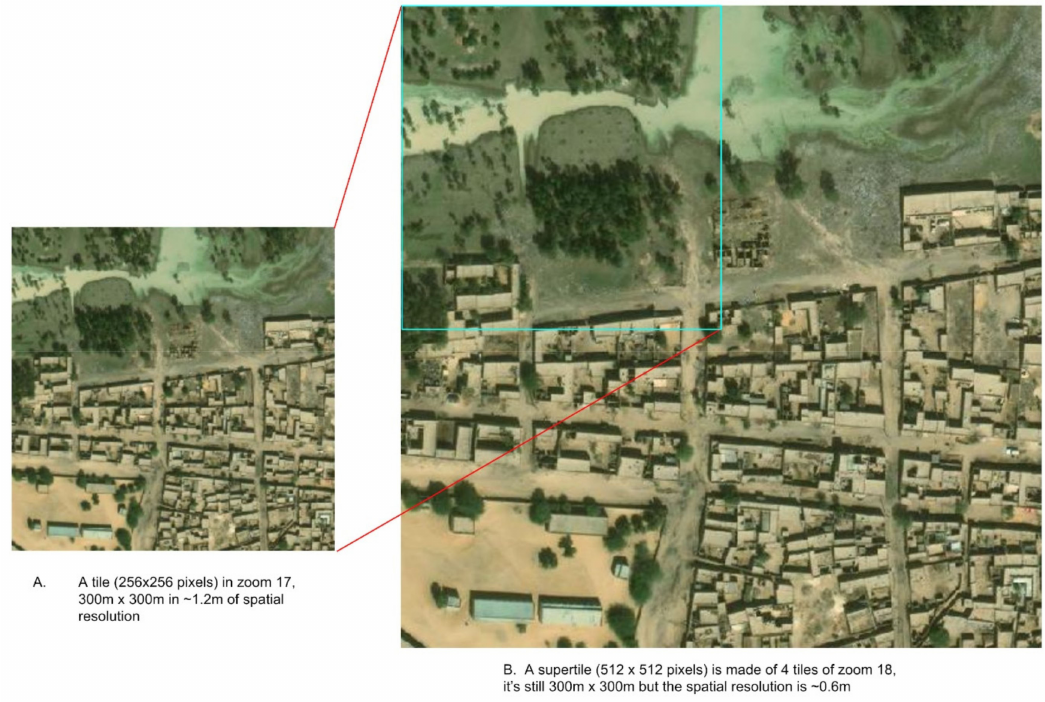
Figure 8. A sample image